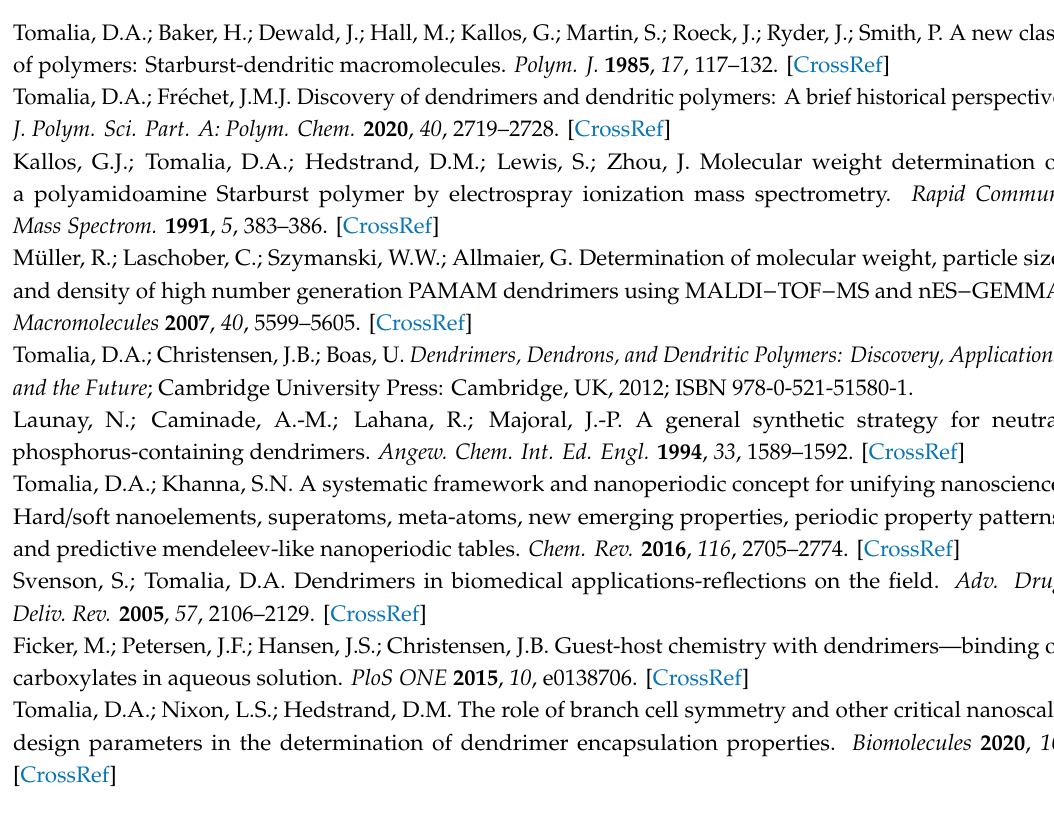
Supplementary Materials: The following are available online. Figure S1: 13 C-NMR spectra of core-shell tecto(dendrimer) Structure (B); Figure S2: 13 C-NMR spectra of core-shell tecto(dendrimer) Structure (C);